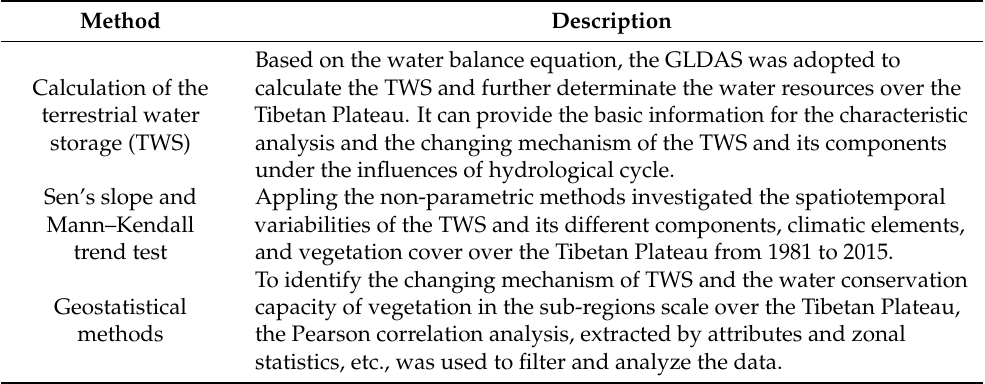
Table 2. Critical description of the methodologies in the current